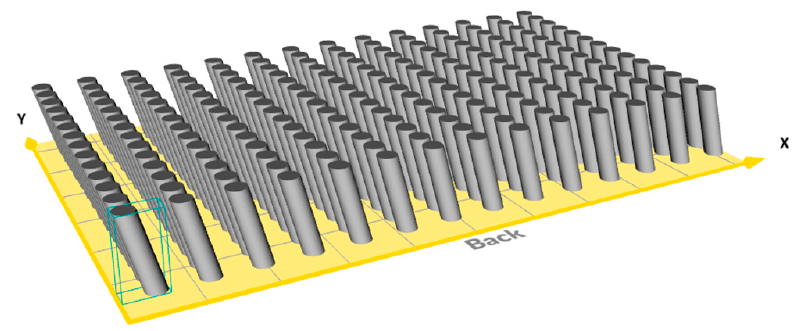
Figure 4. Components (196 in number) of CG2 arranged on the building platform.